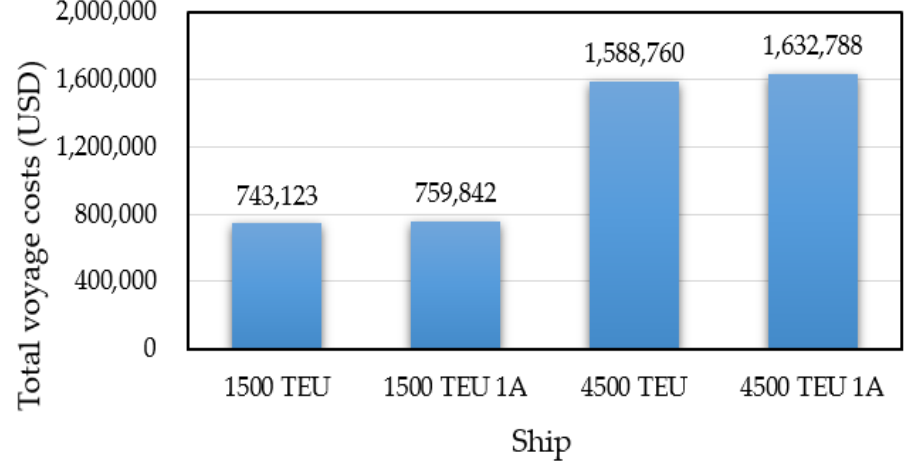
Figure 6. Total voyage costs for the Europe sea route and Northeast Passage.